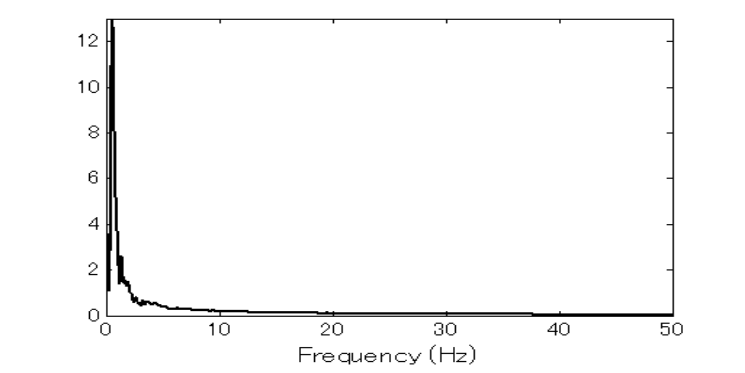
Figure 6. Frequency response curve of the system.